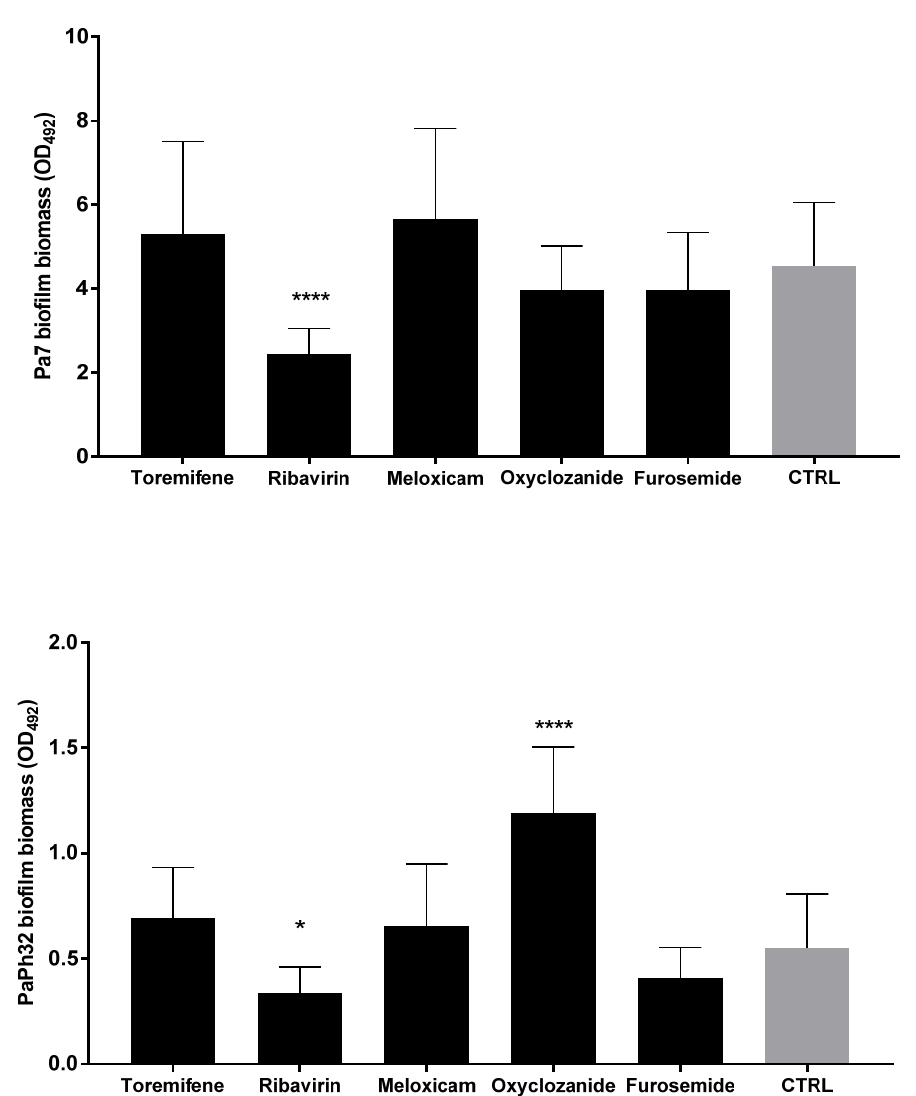
Figure 6. Biofilm dispersal activity of drugs not active against planktonic cells. The efficacy of drugs in disrupting 24 h mature biofilms was assessed using a crystal violet assay. Each drug was tested at the maximum concentration tested in MIC assays: 1.024 µg/mL for all drugs except for Toremifene (256 µg/mL). Results are expressed as mean + SD of the residual biofilm biomass (OD 492 ) after 24 h of exposure. Control samples (CTRL) were not exposed to the drug. Statistical significance at ordinary one-way ANOVA + Holm–Sidak’s multiple comparisons post-test: * p < 0.05, **** p < 0.0001 vs. CTRL.